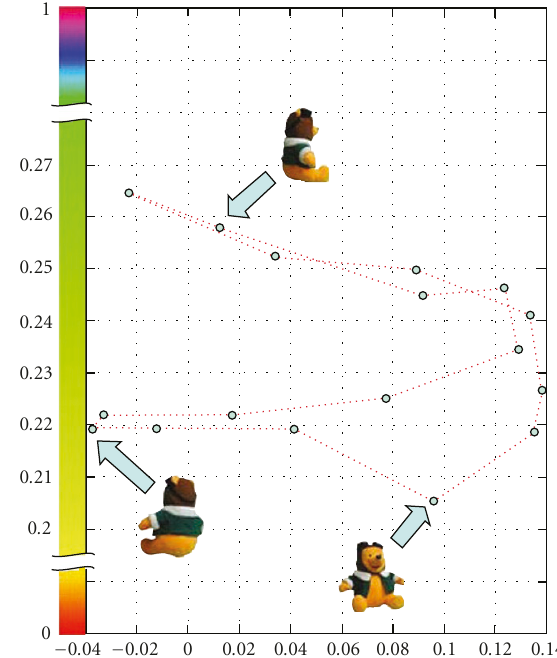
Figure 4: A curve representing an object movie in the feature space. Each feature point corresponds to a view of the